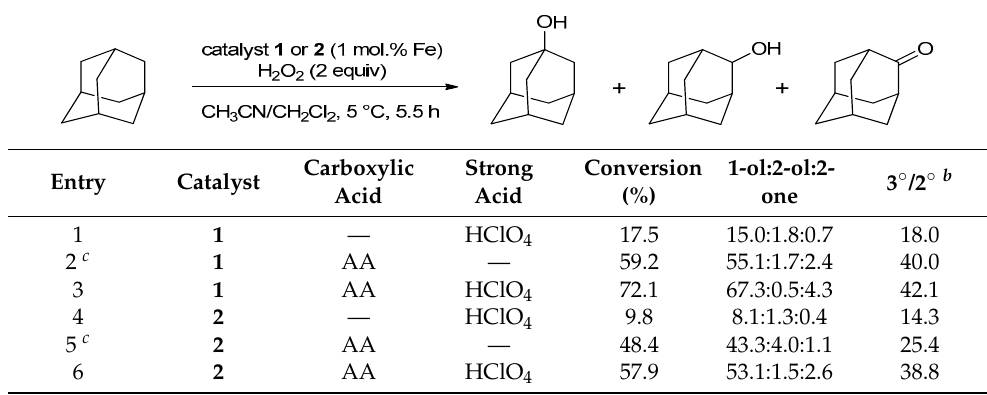
Table 2. The effect of HClO 4 on the regioselective oxidation of adamantane with H 2 O 2 in the presence of complexes 1 and 2 a .